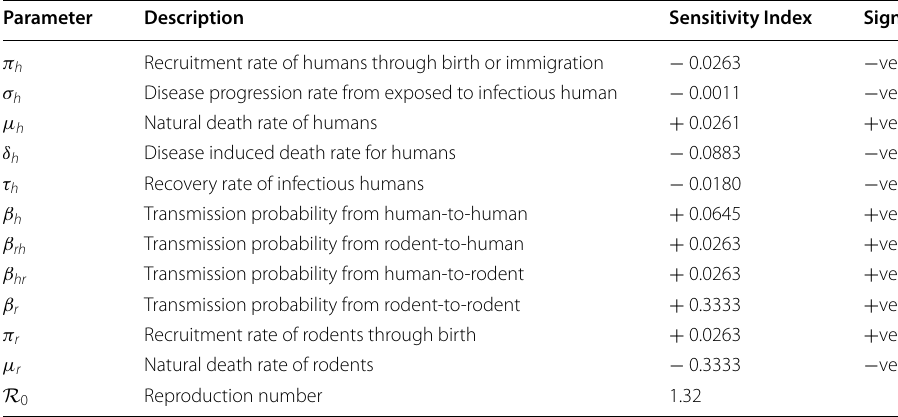
Table 3 Normalized sensitivity index of the reproduction number (9) parameters Parameter Description Sensitivity Index Sign π h Recruitment rate of humans through birth or immigration